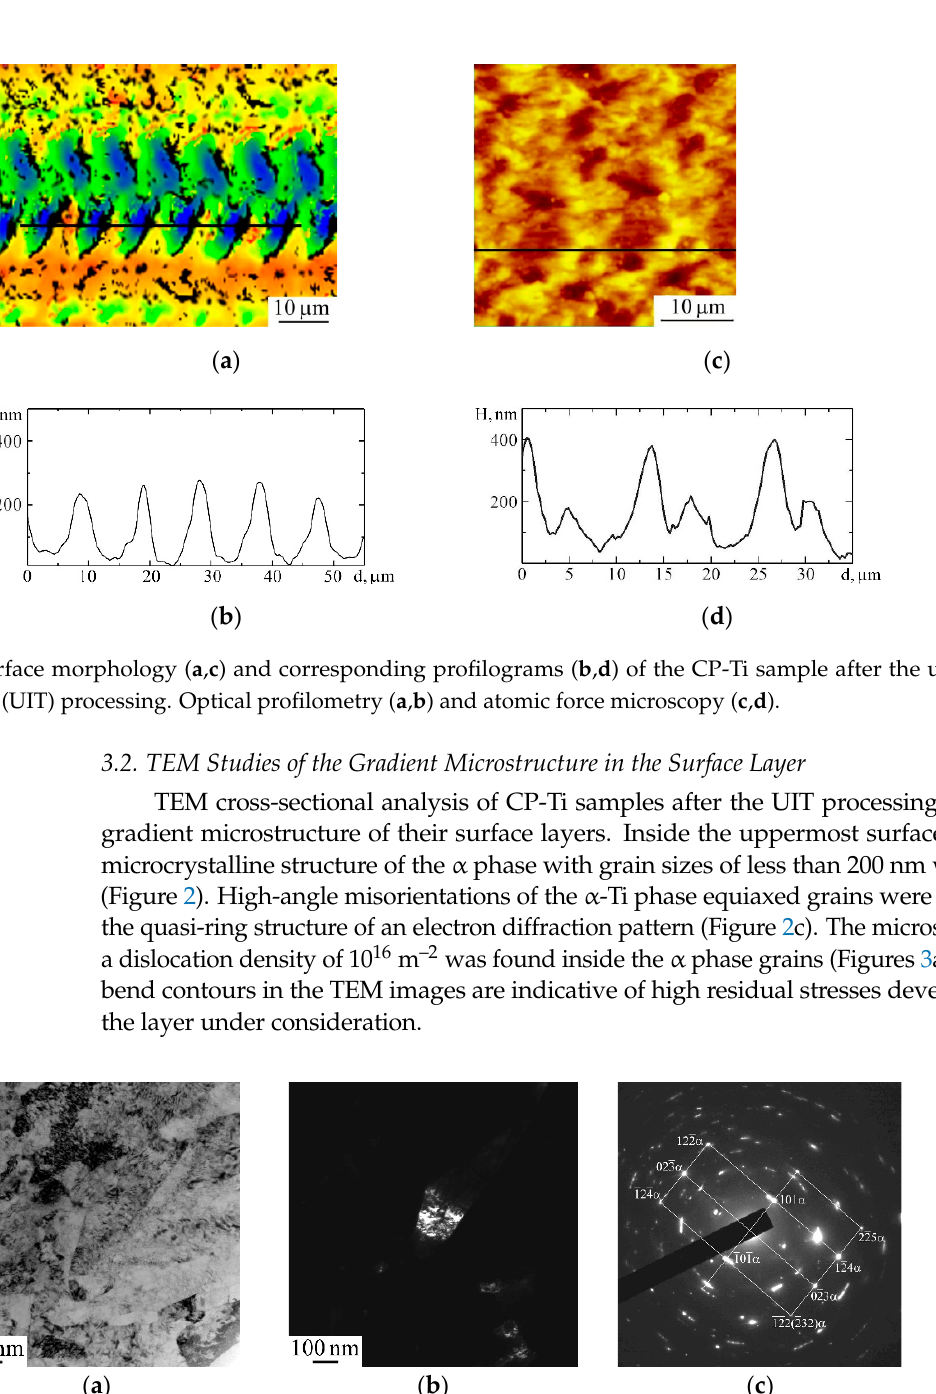
Figure 2. TEM bright- ( a ) and dark-field ( b ) images and associated selected area electron diffrac- tion (SAED) patterns ( c ) of the microstructure of the uppermost surface layer of the CP-Ti sample after the UIT processing. TEM dark-field images were obtained with the 101(2(cid:3364)32) α -Ti reflection.